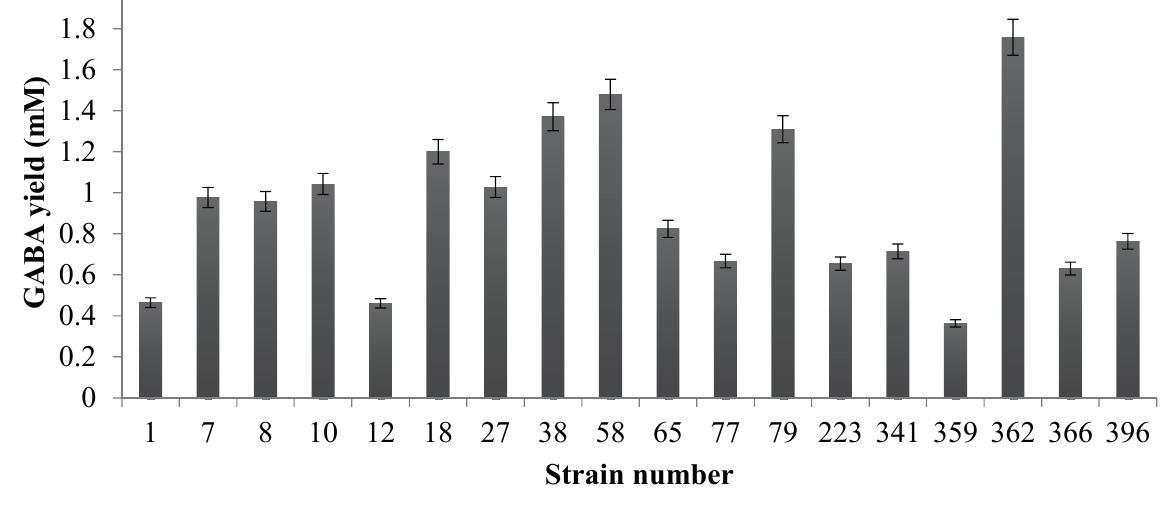
Figure 1. Comparison of GABA production by 18 LAB strains isolated from honeycomb and honey stomach of honeybees. The strains were cultivated in MRS broth containing 50 mM initial glutamic acid at 30 °C for 60 h. The GABA content in the supernatants was analyzed by HPLC method as described. Data are expressed as mean ± SD from triplicate